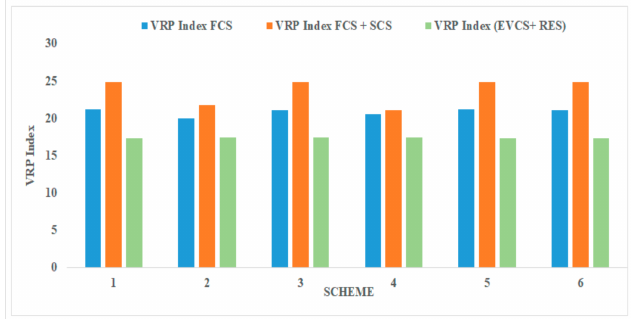
Figure 17. VRP index of the IEEE 123-bus system.